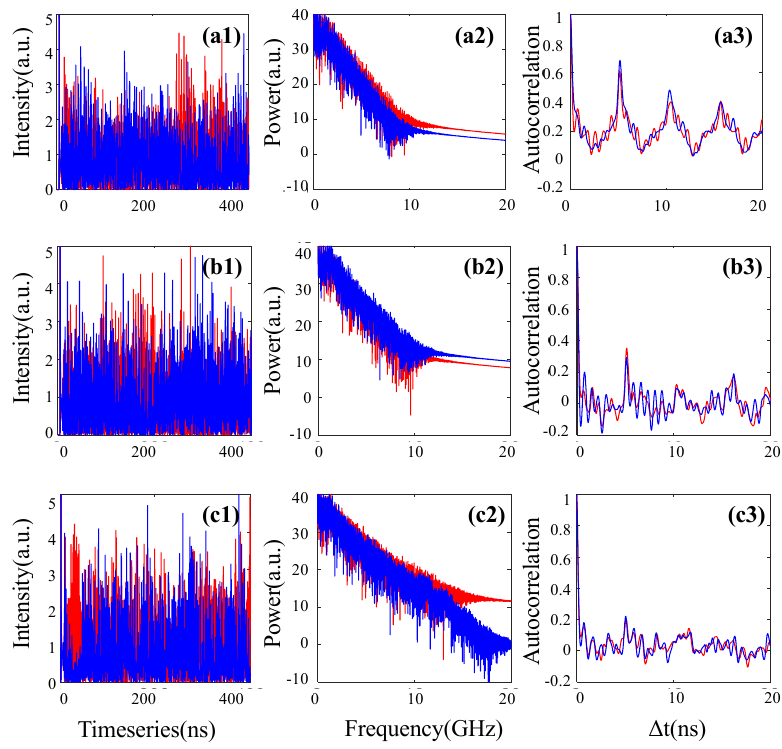
Figure 3. The timeseries ( a1 – c1 ), power spectrum ( a2 – c2 ) and ACF ( a3 – c3 ) of the MSRL, where ( a1 – a3 ) α = 3.5, ( b1 – b3 ) α = 5, and ( c1 – c3 ) α = 8. The blue line denotes CW, and the red line denotes CCW. The parameters are set as: η = 4 ns − 1 , τ f = 6 ns, and µ = 2.5.